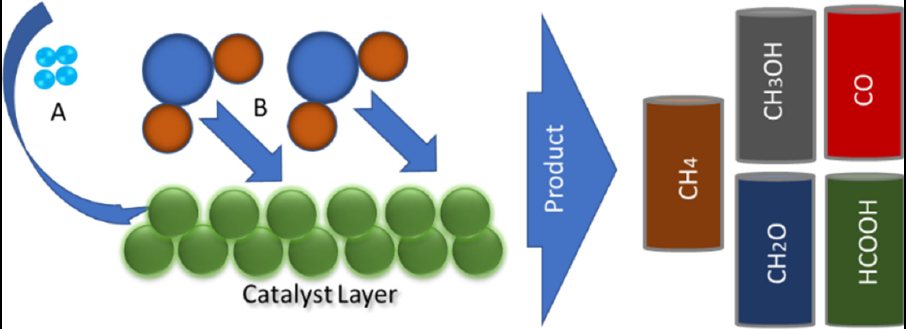
Figure 8. Conversion of CO 2 to value ‐ added products by metal oxides.